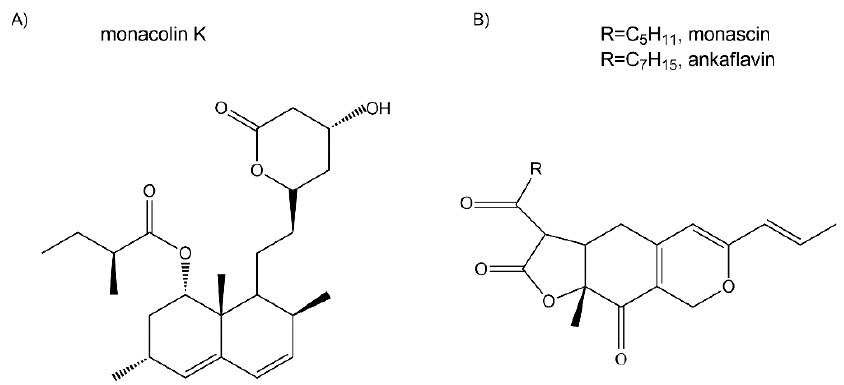
Figure 4. Chemical structure of monacolin K, monascin and ankaflavin. ( A ) Monacolin K; ( B ) Monascin and